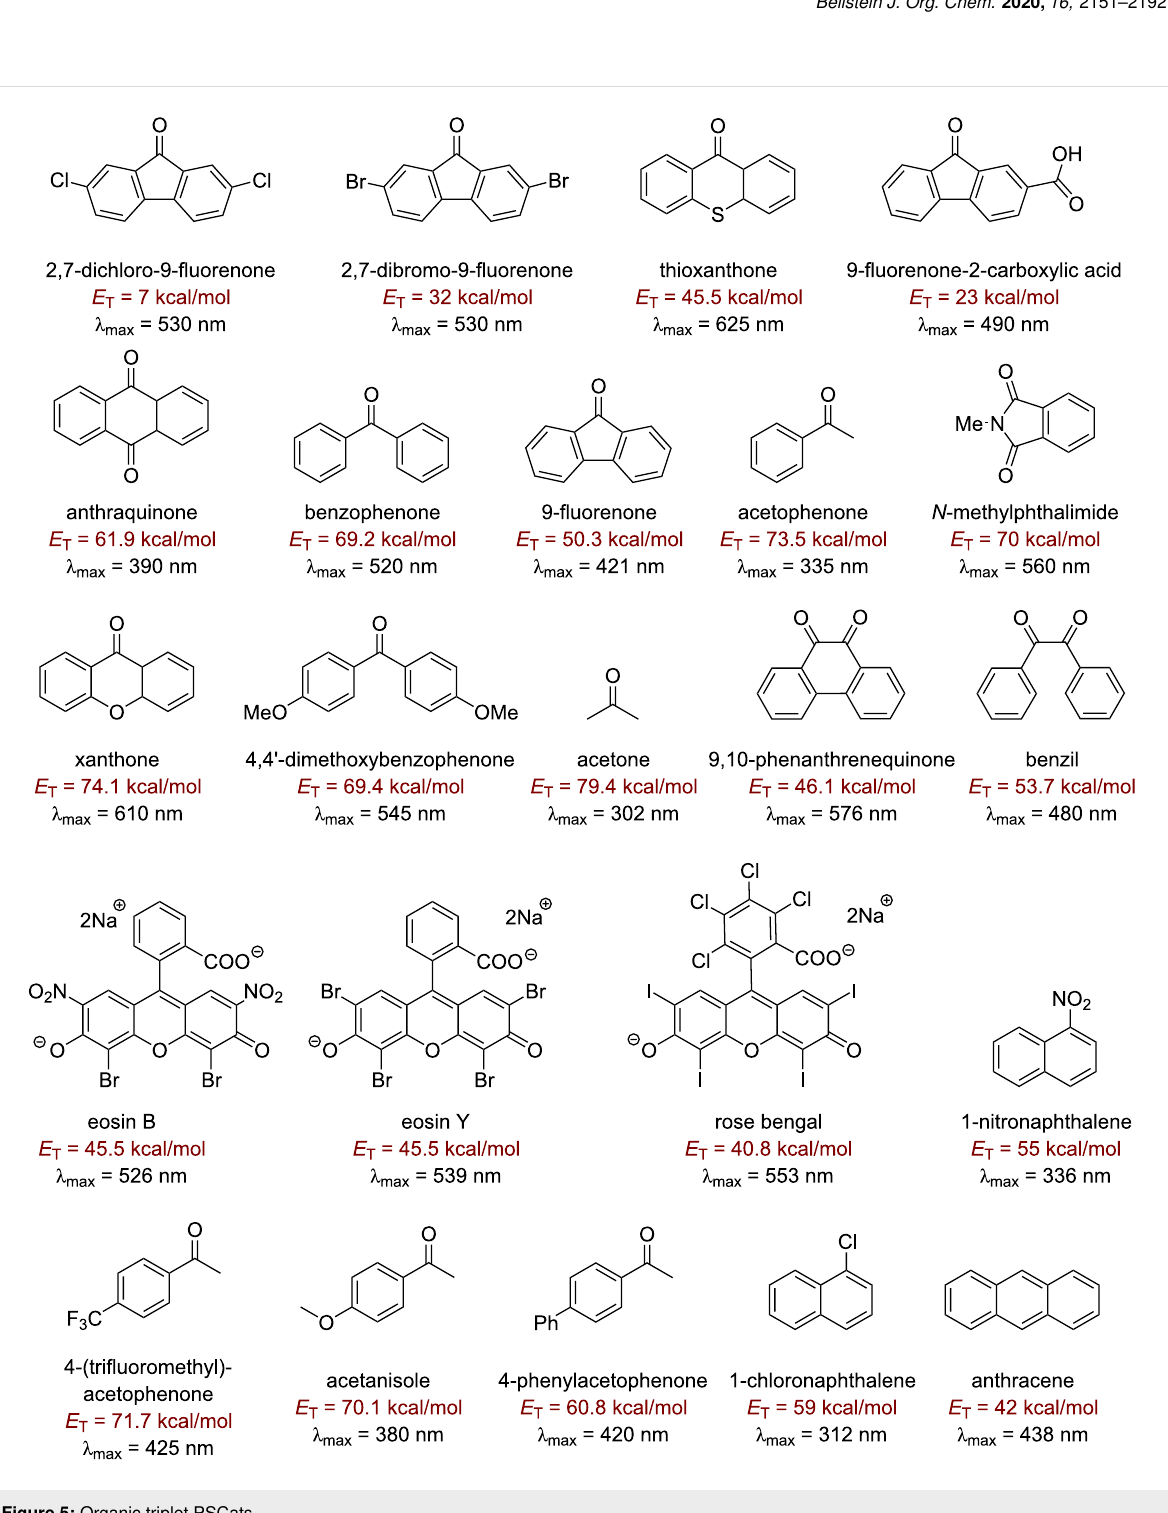
ammonium fluoride (TBAF) [4] as nucleophilic fluorine sources, the high reactivity of alternative electrophilic fluorine sources, such as fluoroxysulfates and hypofluorites [177-179], renders their employment in synthesis problematic. The high demand for a safe, stable and highly reactive electrophilic fluo-